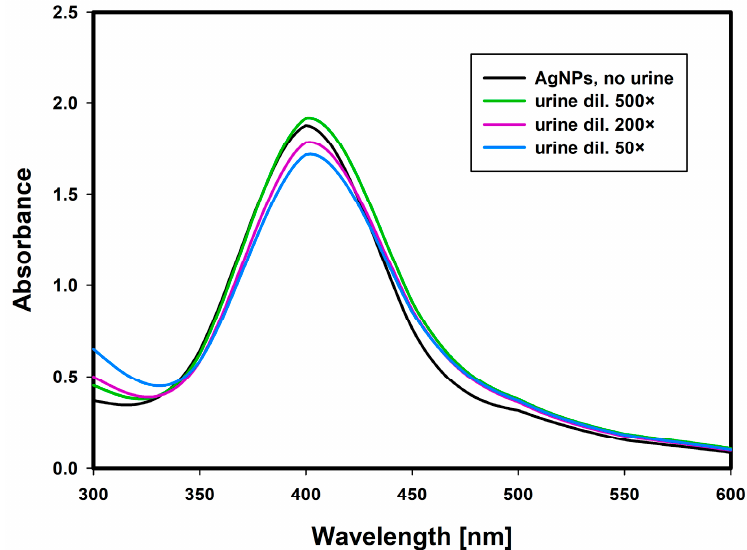
Figure 4. UV/Vis spectra of silver nanoparticle solutions after addition of different volumes of urine samples from healthy donors—control study, representative example. The dilutions of urine samples were: 50×, 200×, 500× —the same as in the test with FLC-containing samples. The interaction of free monoclonal light chains coated on silver nanoparticles was also investigated using TEM imaging (Figure 5). Figure 5a shows single silver nanoparti- cles coated with immunoglobulin free light chains (10 mg/L (500 nM)), stable, with a pro- tein corona (which corresponds to variant 1 described above). Figure 5b shows aggregates (variant 2).